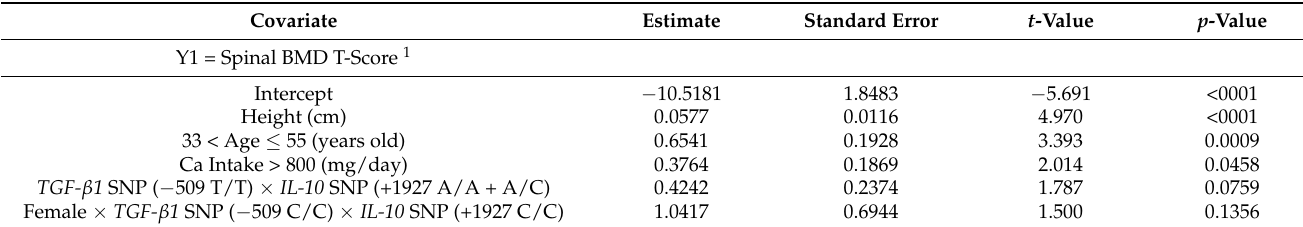
Table 3. Multivariate analyses of the predictors of spinal bone mineral density (BMD) T-scores using MLR models. Covariate